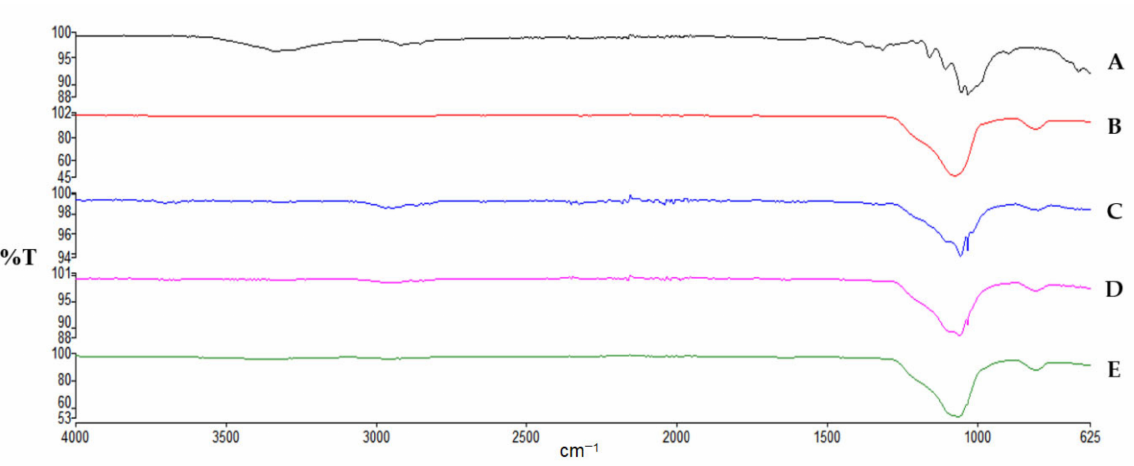
Figure 1. IR spectra of (A) MCC, (B) SiO 2 and MCC-SiO 2 conjugates prepared in ratio; (C) 1:1, (D) 1:2.5 and (E) 1:5.